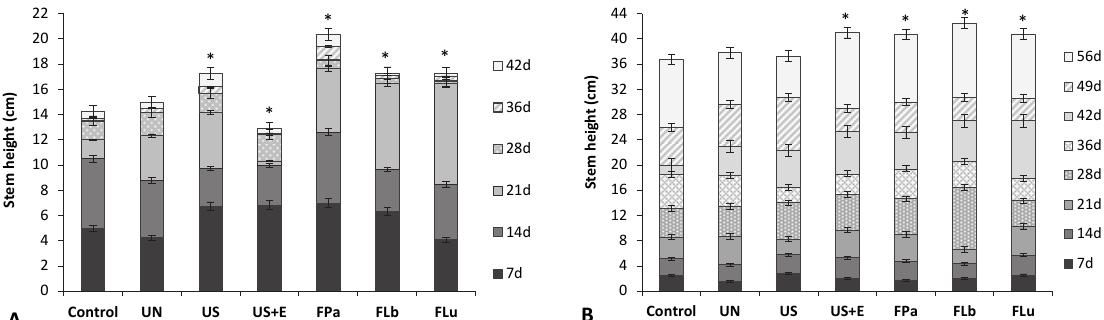
Figure 3. Influence of the rice bran (RB) additives on bean ( A ) and tomato ( B ) plant stem heights. Control: PGS; PGS with RB: UN, untreated; US, ultrasonicated; US+E, ultrasonicated and enzyme- hydrolyzed; F Pa , F Lb , F Lu , fermented with appropriate lactic acid bacteria strain. * significant at p < 0.05 compared to the controls.